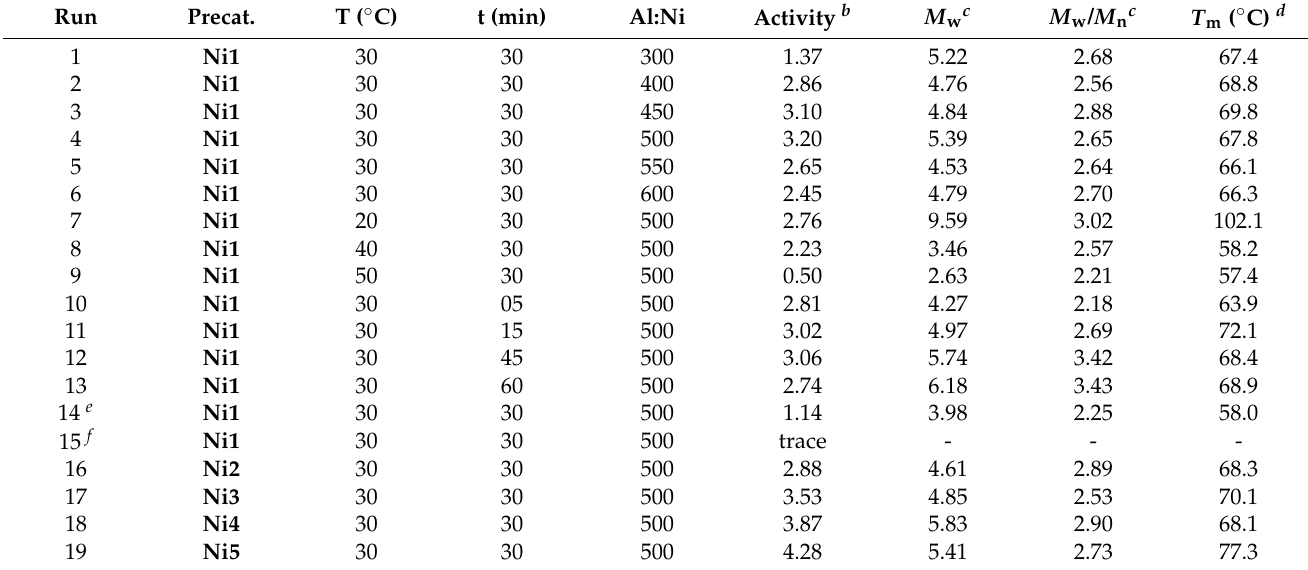
Table 3. Polymerization results using Ni1–Ni5 and EtAlCl 2 a .